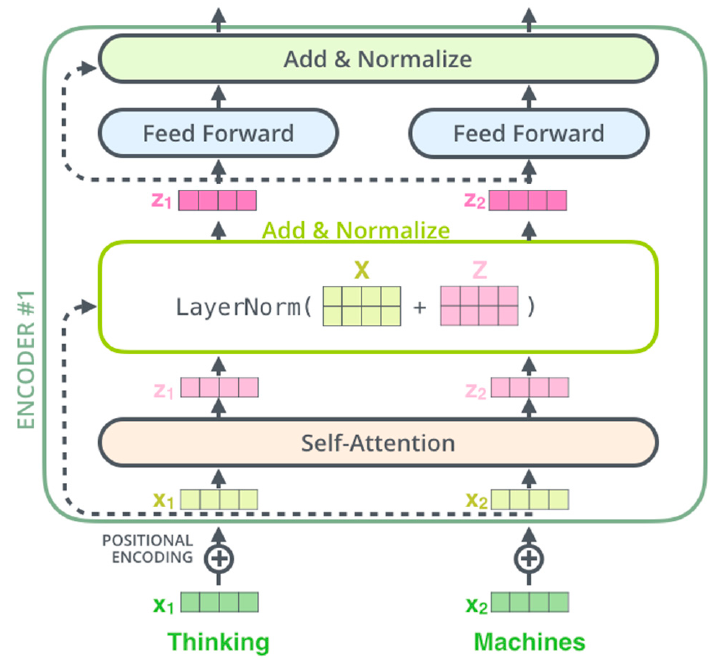
Figure 2. Detailed architecture of the first encoder in a BERT stack [34].